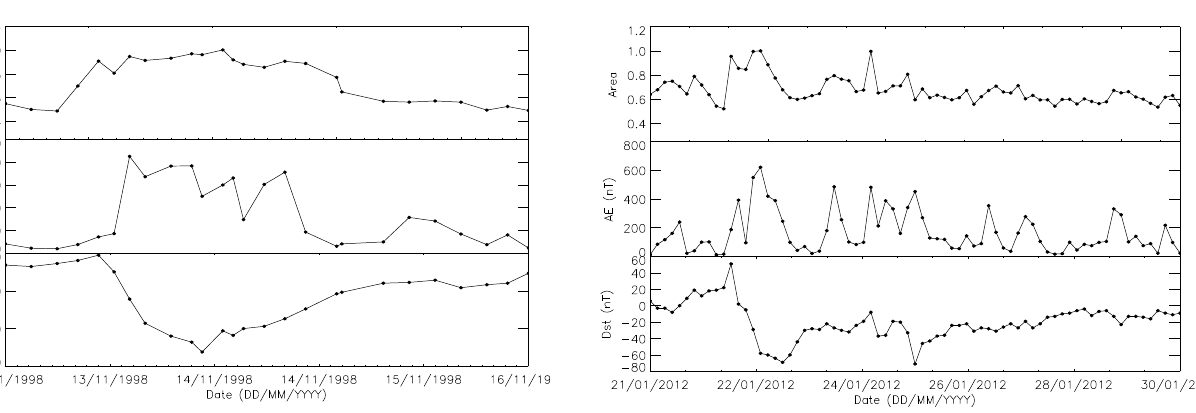
Figure 10. The variations of the area and the AE and Dst indices during 12–16 November 1998. The black dots represent the selected time to be calculated and the y axis of top panel has been normal- ized.